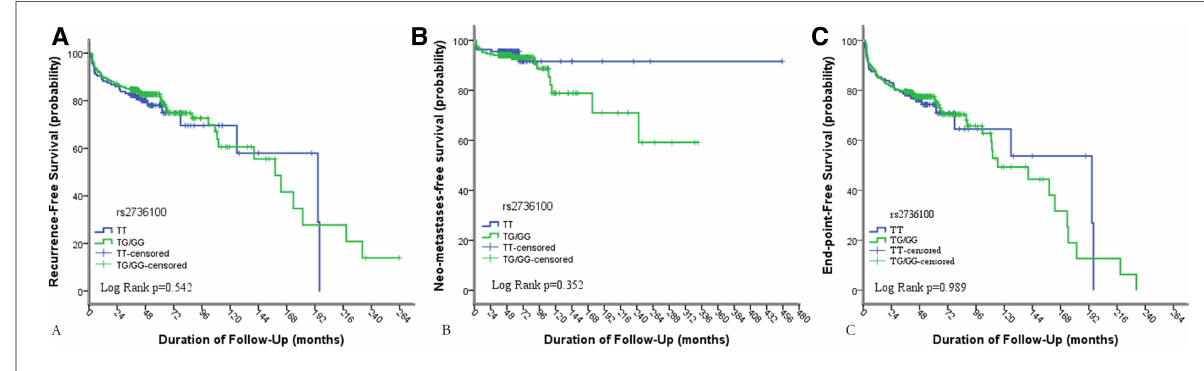
FIGURE 1 Results of Kaplan – Meier analyses of the impacts of TERT rs2736100 genetic polymorphism on ( A ) the recurrence-free survival of patients with PTC; ( B ) the neo-metastasis-free survival rates of patients with PTC, 14 patients were excluded because of having distant metastasis at initial diagnosis; ( C ) the overall recurrence-free (the recurrenceoflymph nodes and neo-distant metastases was combined as an end-point event) survival rates ofPTC.